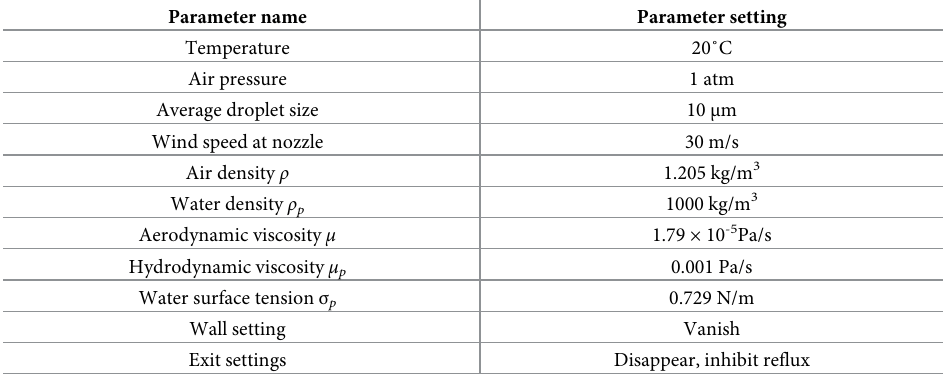
Table 1. Working environment parameter